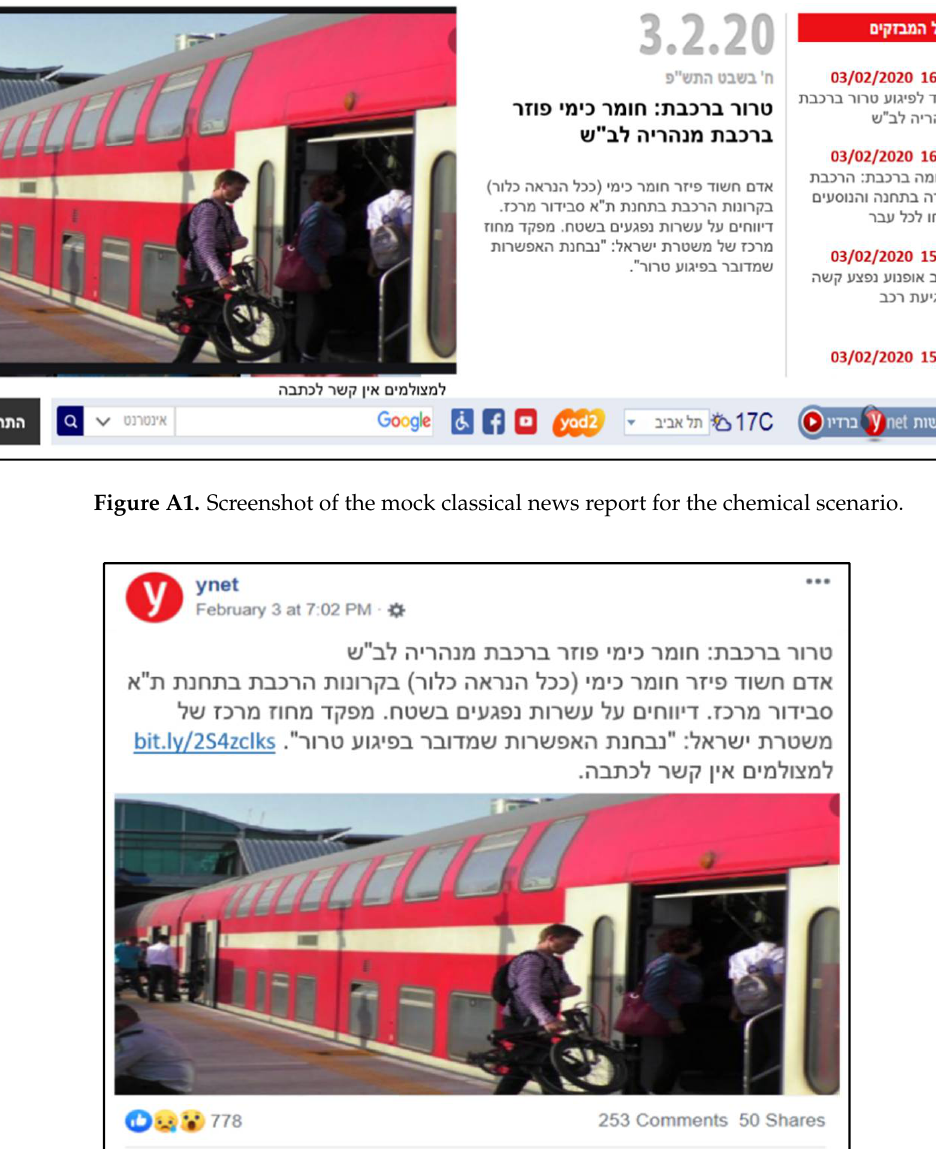
Figure A3. Screenshot of the mock social media rumor (fake news) post for the chemical scenario. The text on the rumors/fake news post (Figure A3) reads: “In short–rush to the hos- pitals to get checked! They aren’t telling you the truth about the terror attack on the train. On site there are way more casualties and dead than reported on the news. Chlorine is a dangerous gas that chokes people and it is being used as a chemical weapon in Syria and Iraq”. References 1.